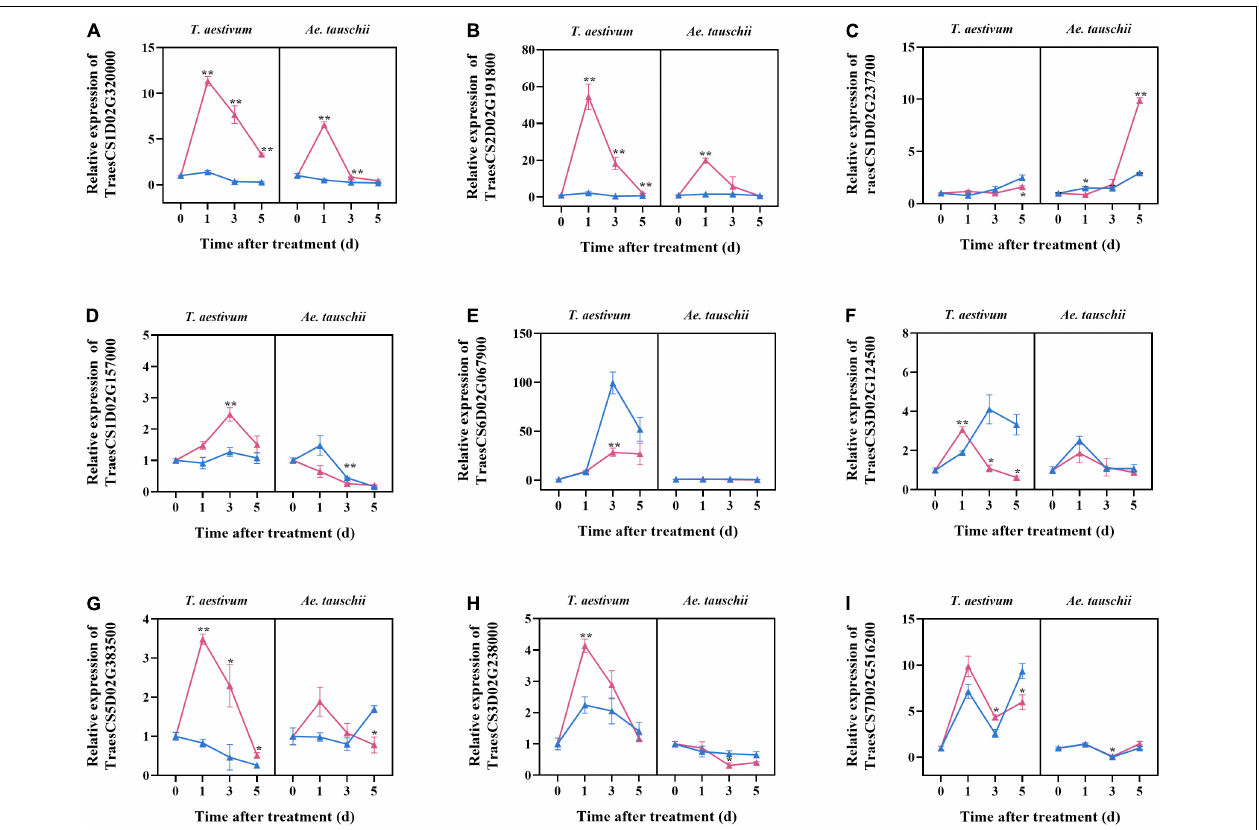
FIGURE 5 | The relative expression levels of nine candidate genes selected from transcriptome analysis. The samples were collected from tillers buds of T. aestivum and Ae. tauschii at 0, 1, 3, and 5 days after 2,4-D isooctyl ester treatment. At 0 days after treatment, the relative expression level of target genes in untreated T. aestivum and Ae. tauschii seedlings was set 1, respectively. Red line represents seedlings with 2,4-D isooctyl ester treatment (treatment); blue line represents seedlings without 2,4-D isooctyl ester treatment (mock). Error bars represent the mean ± SD ( n = 3). The significant difference between mock group and treatment group is indicated ( t -test, * P < 0.05, ** P < 0.01). The annotations of gene ID (A–I) are as shown in Table 2